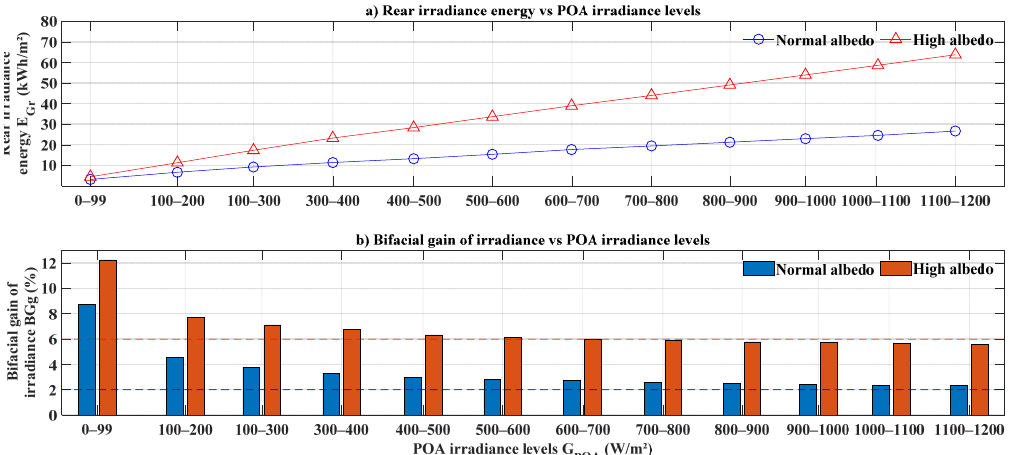
Figure 4. Measured rear-irradiance for normal and high albedos, the BGg was around 2% and 6% for normal and high albedo, respectively. ( a ) Measured rear irradiance energy vs. G POA . ( b ) Measured BGg vs. G POA .